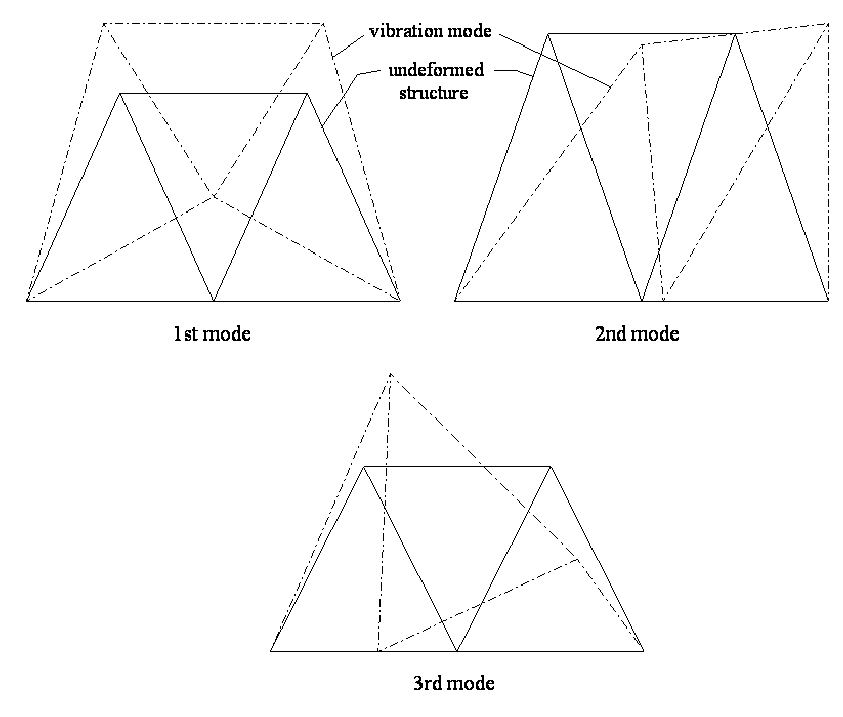
Fig. 10. The first three natural vibration modes for the plane truss CEM (7e